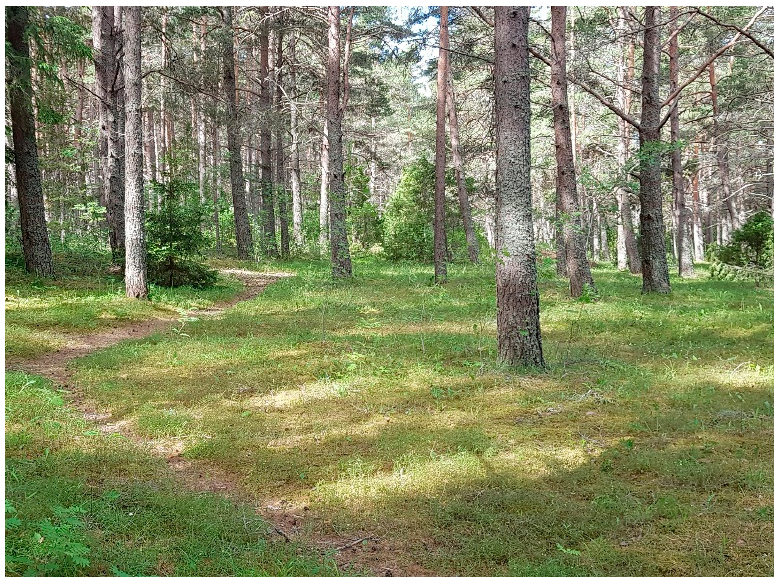
Figure 6. A forest where Chimaphila umbellata and Moneses uniflora thrive. The site at Billudden, province of Uppland, harboring the largest populations of these species recorded in this study. (Photo: the author, June 2021). the author, June